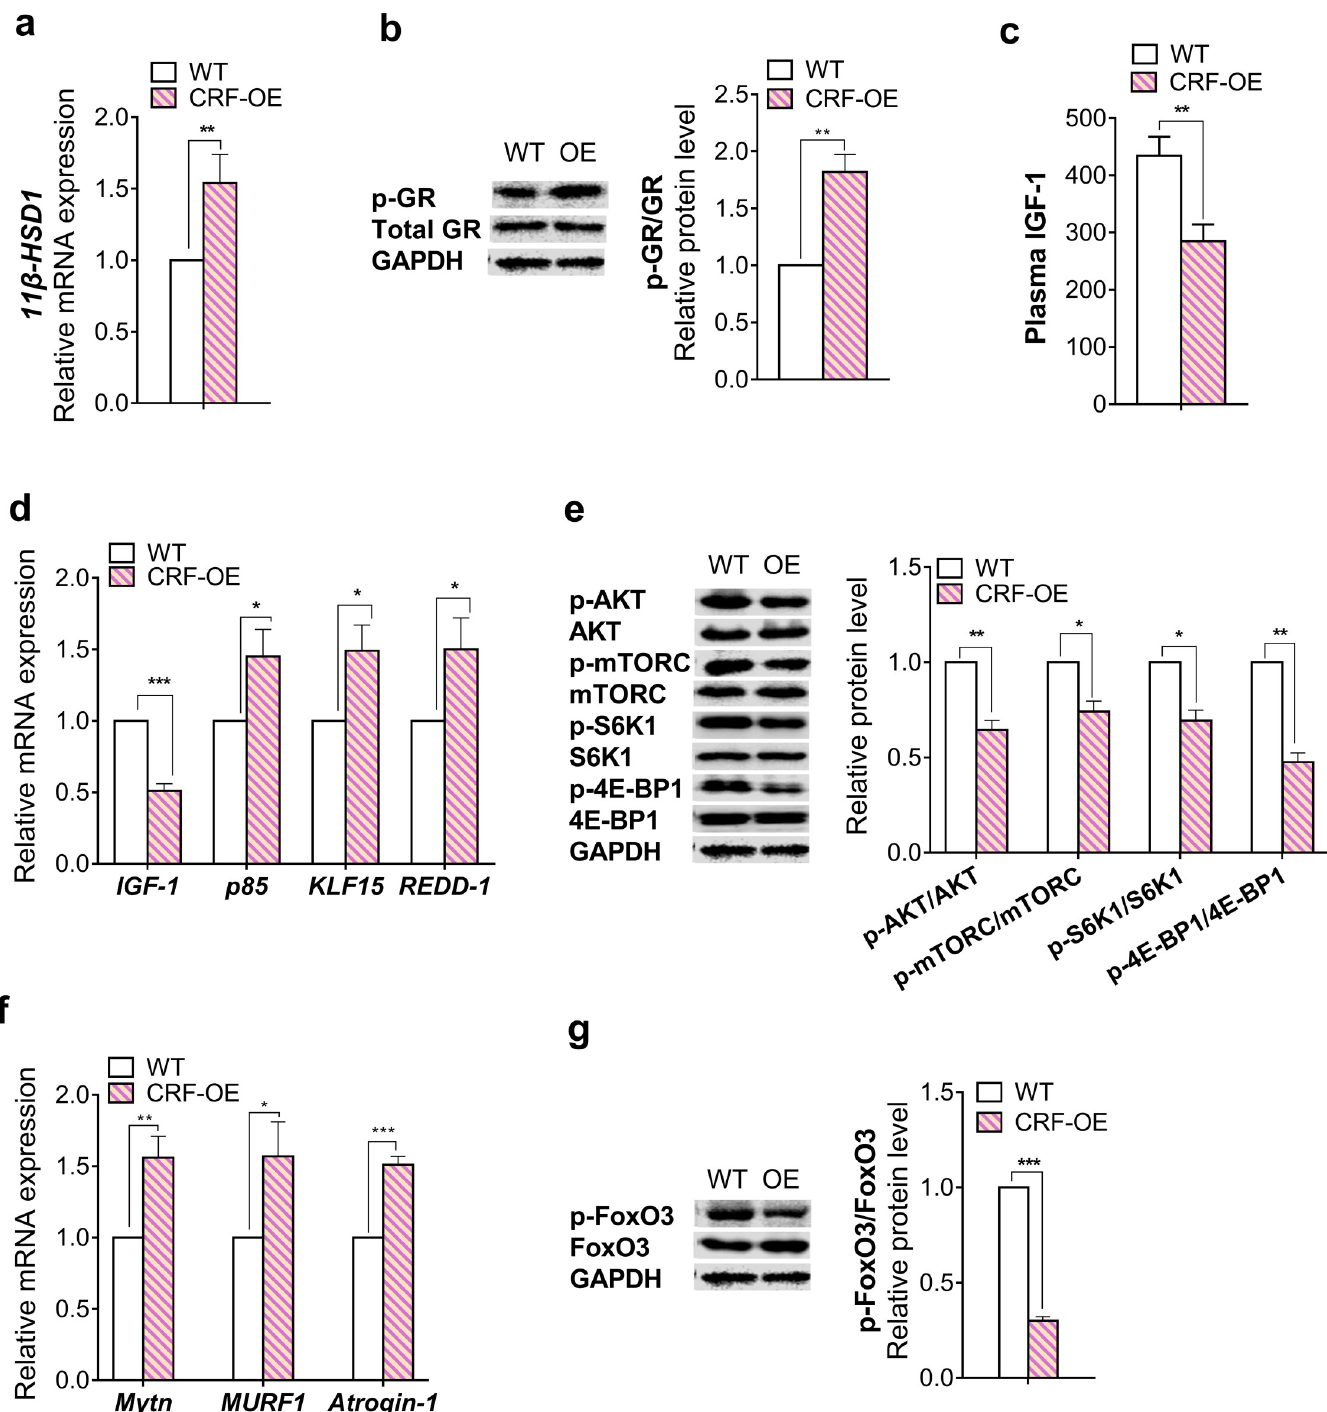
Fig 4. Reduced protein synthesis and stimulated breakdown signaling were observed in CRF-OE mice. (a) qRT–PCR analysis of relative 11beta-HSD1 mRNA expression. (b) Western blot analysis of glucocorticoid receptor (GR) phosphorylation. (c) Plasma IGF-1 concentration. mRNA and protein expression related to muscle protein synthesis were examined by (d) qRT–PCR and (e) western blot analysis, respectively. mRNA and protein expression related to muscle protein breakdown were examined by (f) qRT–PCR and (g) western blot analysis, respectively. � P < 0.05, �� P < 0.01, and ��� P < 0.001 compared to WT mice. Values represent the mean ± s.e. m. of three experiments. In each experiment, sample was pooled from 5–6 mice in each group.